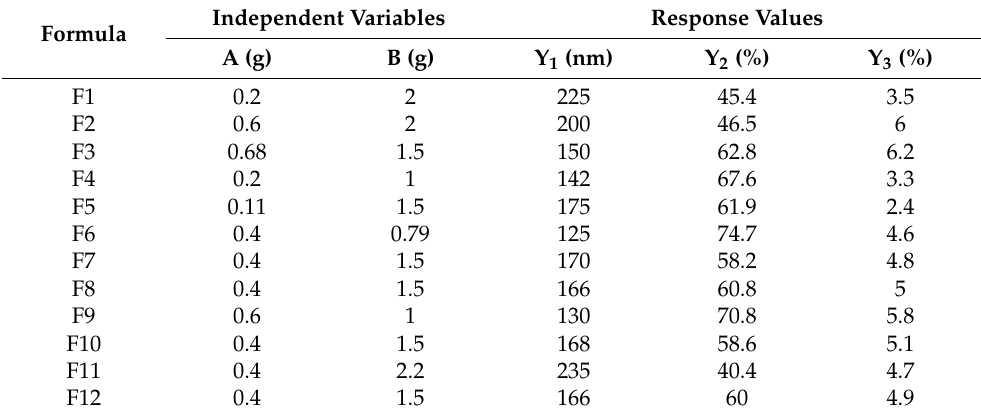
Table 1. Experimental design for DPE ‐ NE formulations and their corresponding observed values of response.